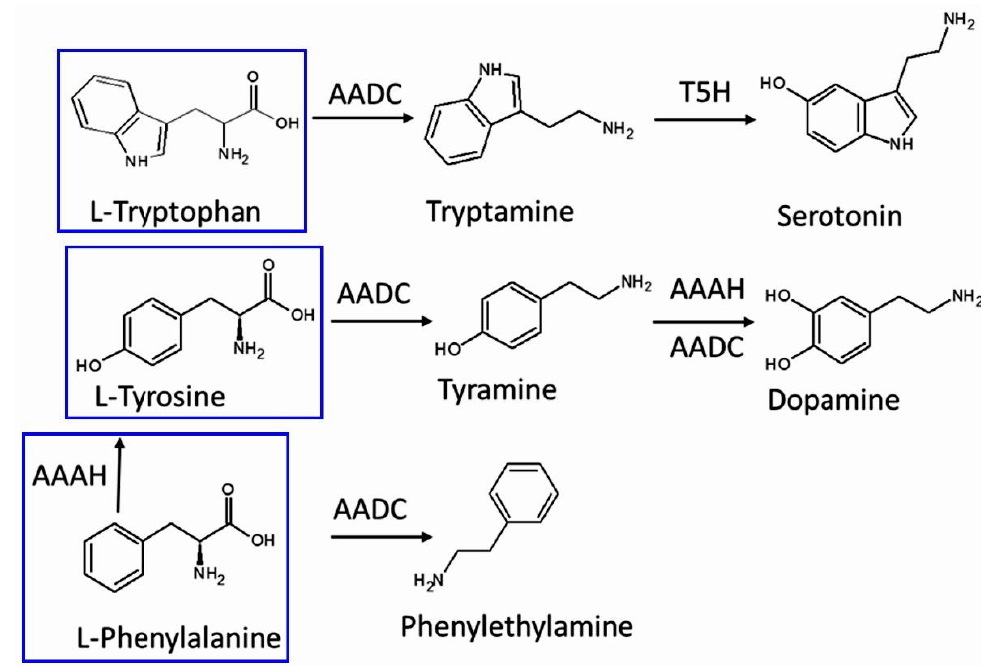
Figure 8. Chemical structures and biosynthetic formation of the selected biogenic amines/amino acids (tryptophan, tryptamine, serotonin, tyrosine, tyramine, dopamine, phenylethylamine, and phenylalanine). AADC: Aromatic amino acid decarboxylase (DDC); T5H: Tryptamine-5-hydroxylase; AAAH: Aromatic amino acid hydrolase.